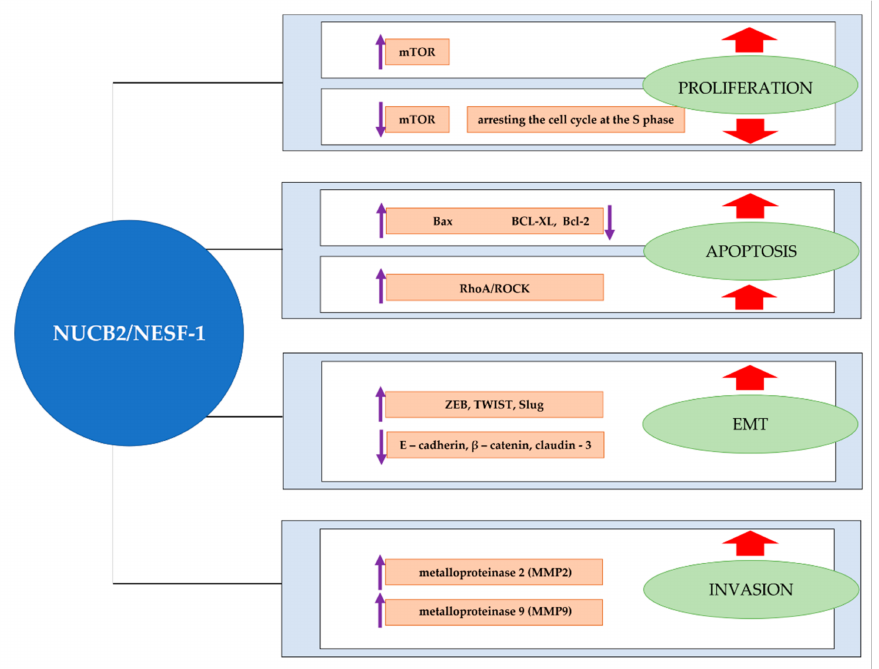
Figure 4. Involvement of NUCB2/NESF-1 in cancer-related processes. NUCB2/NESF-1 may stimu- late cancer cell proliferation and apoptosis via the mTOR signaling cascade. NUCB2/NESF-1 also enhances EMT and cancer cell invasion by regulating gene expression associated with these processes, such as TWIST, Slug, and MMP-2 or MMP-9. On the other hand, NUCB2/NESF-1 plays the role of a tumor suppressor promoting apoptosis and in cancer cells via mTOR and RhoA/ROCK